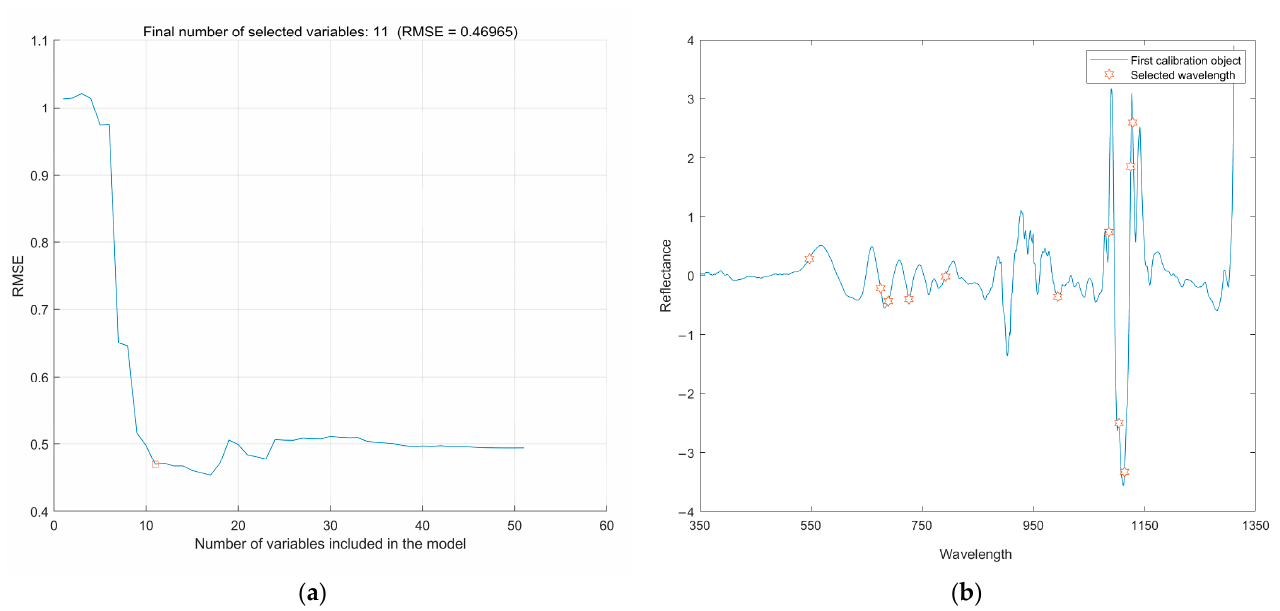
Figure 8. The process and result of SPA. Number of selected wavelengths ( a ) and distribution of selected wavelengths ( b ). Table 3. Characteristic wavelengths.